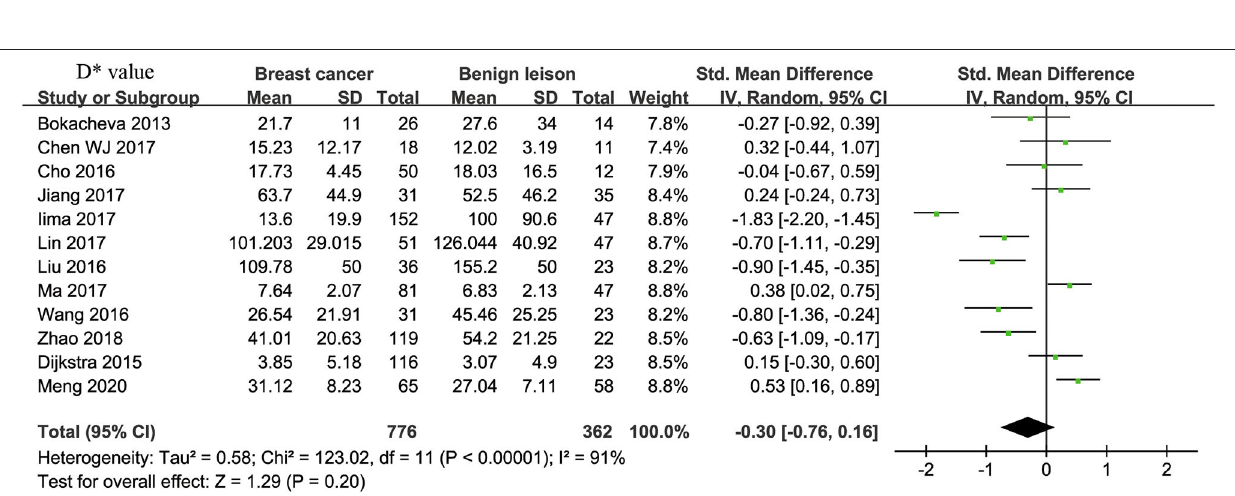
FIGURE 5 | Forest plot of the mean value of pseudodiffusivity (D*) between malignant and benign breast lesions. The standardized mean differences (SMDs) indicated that there is no statistical difference between breast cancers and benign lesions in D* value.